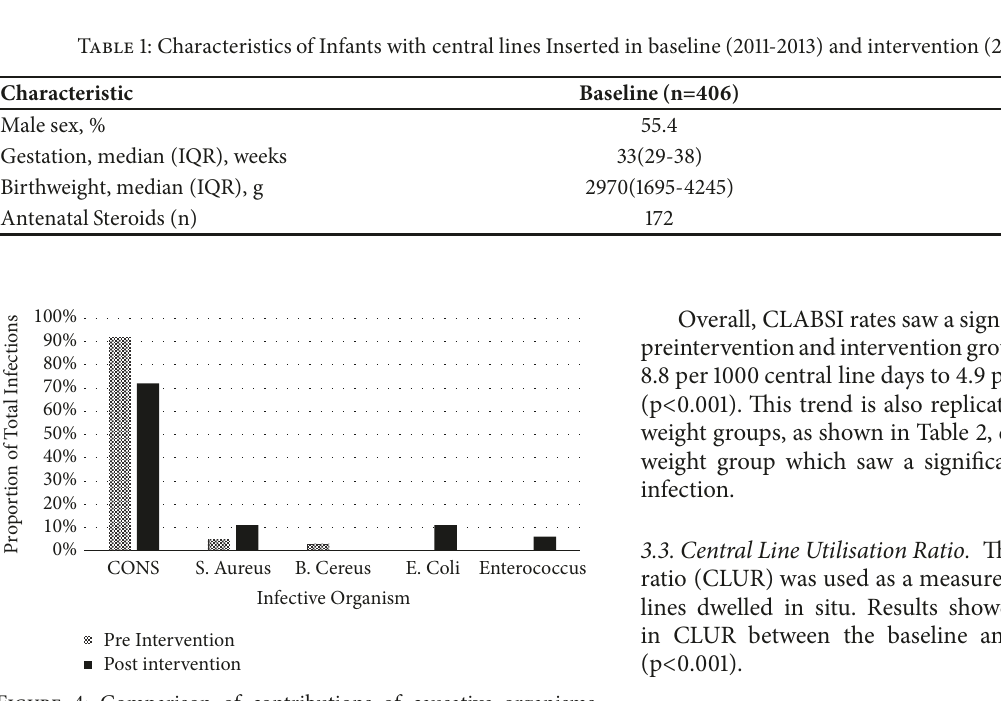
Figure 4: Comparison of contributions of causative organisms in preintervention (2011-2013) and postintervention (2014-2016)